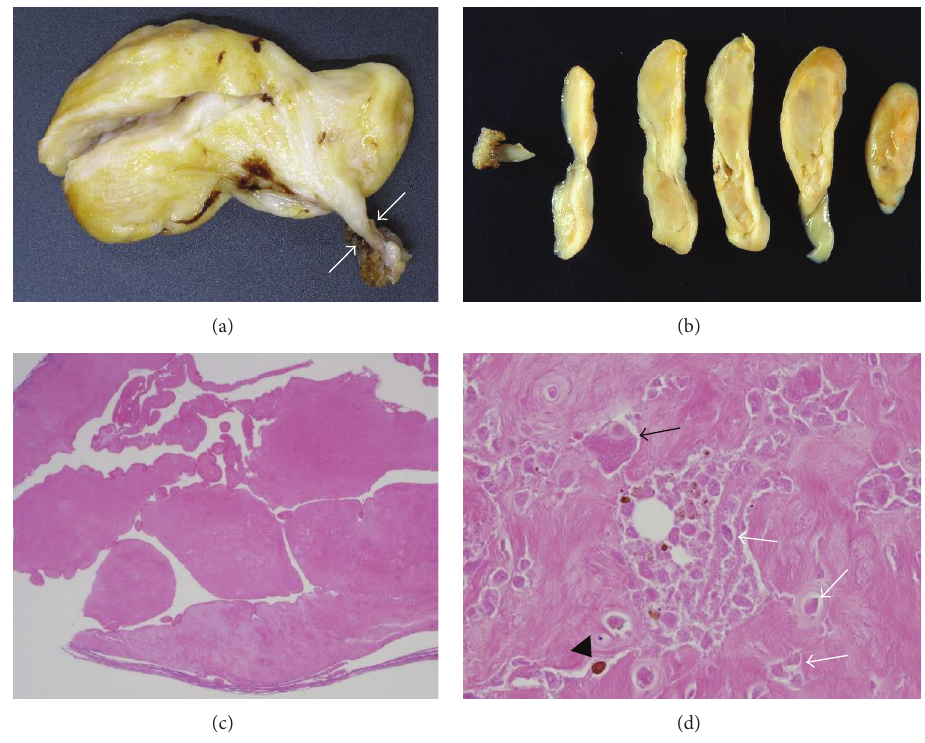
Figure 3: (a) The excised tumor had a pedicle ( white arrows ), and (b) the cut sections revealed tumor necrosis except in the margins. (c) A histological image shows a nodular and papillary structure and the presence of synovial cells, histiocytes, and hyperplasia (original magnification × 1.25; hematoxylin and eosin staining). (d) Histopathological findings: enucleated mononuclear stromal cells ( white arrows ) and multinuclear giant cells ( black arrow ), with hemosiderin in the cytoplasm ( black arrowhead ) (original magnification × 100; hematoxylin and eosin